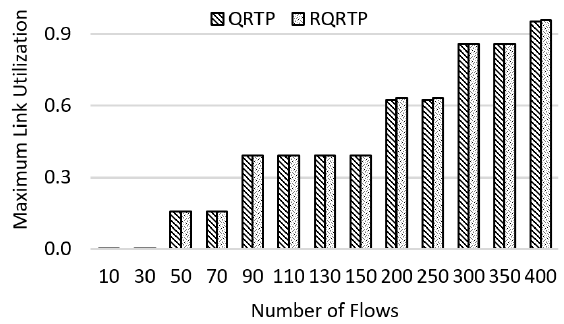
Figure 9. Comparison of link